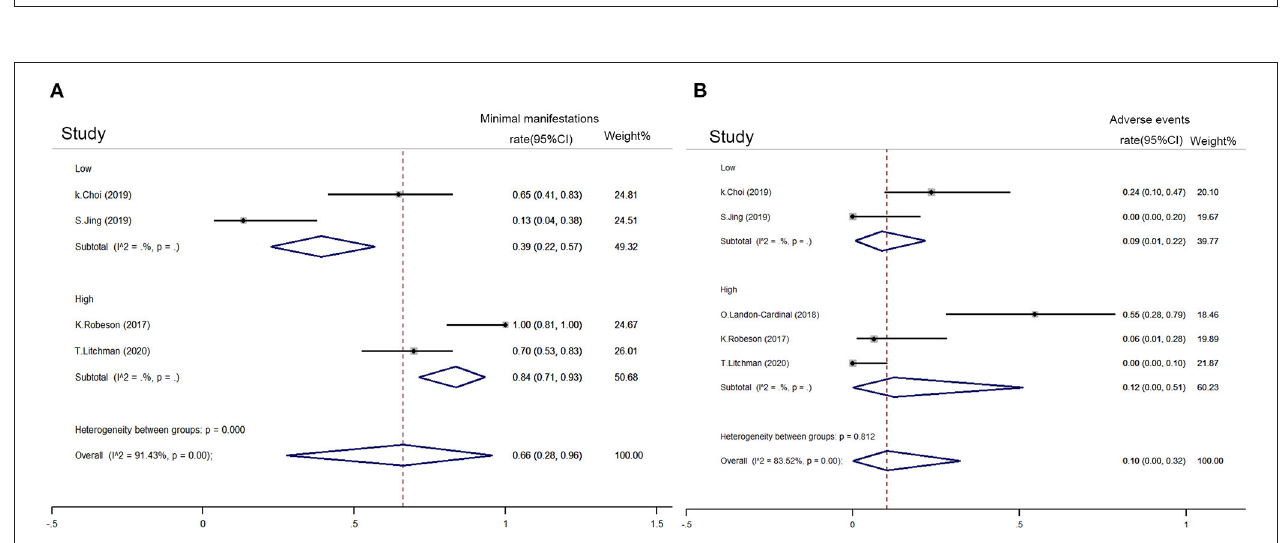
FIGURE 6 | Comparison between refractory MG subgroups with low-dose and high-dose rituximab. (A) Achievement proportion of MM (MG Foundation of America post intervention status) between low-dose and high-dose rituximab on refractory MG. (B) Adverse event density (event rate per patient-year) between low-dose and high-dose rituximab on refractory MG. High-dose rituximab was defined as a dose higher than 375 mg/m 2 twice in a month and vice versa. A random-effect model was used for quantitative synthesis. The high-dose rituximab had better performance in achieving the MM rate than low-doses with similar adverse event density.